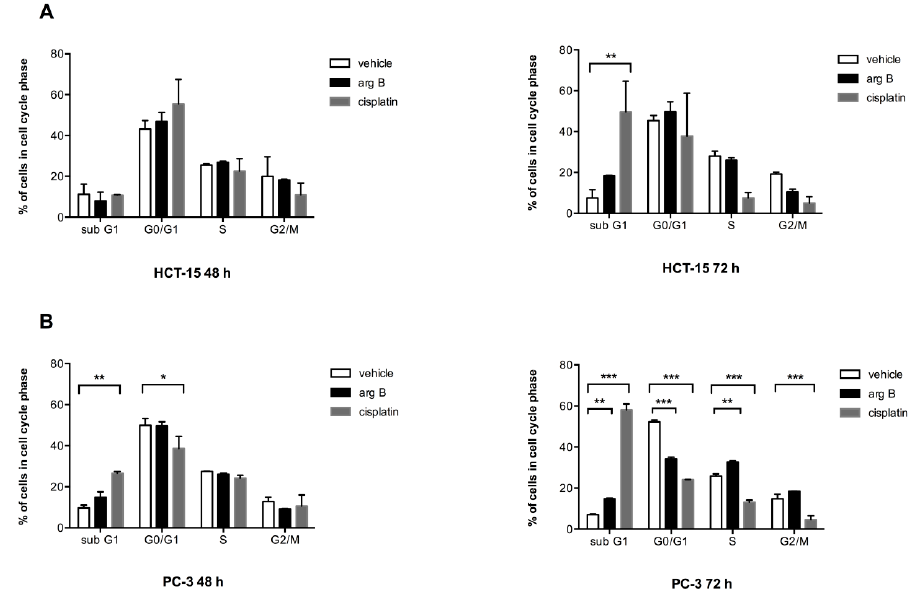
Figure 2. Effect of argentatin B on cell cycle progression. HCT-15 ( A ) and PC-3 ( B ) cells were incubated with 24 μ M or 34 μ M argentatin B, respectively, for 48 and 72 h. As a positive control cells were treated with cisplatin 14 μ M. Negative control cultures received the carrier solvent (0.2% DMSO). The cells were stained with propidium iodide, and the cell cycle distribution was analyzed by flow cytometry using the BD CellQuest Pro Software. Data represent the average of three independent assays. Error bars indicate the standard error of the mean. * p < 0.05, ** p < 0.001, and *** p < 0.0001 vs. vehicle (one-way ANOVA test, and Tukey-Kramer post-test).